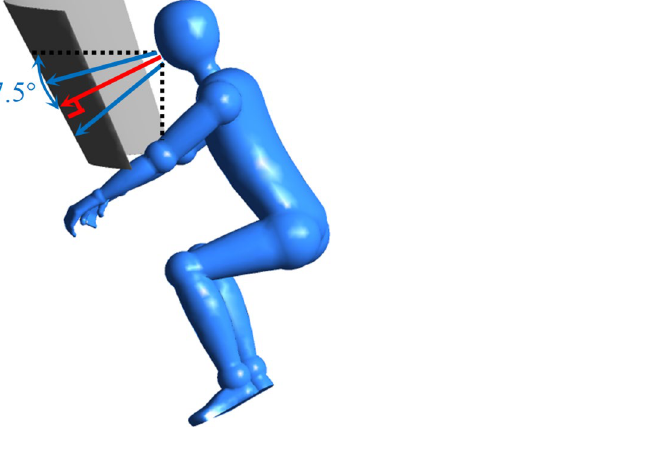
Figure 6. Schematic of the spreading angle of the cough particles. The figure was drawn in Tecplot 360 (version 2016 R2) and Adobe Illustrator (version 16.0).